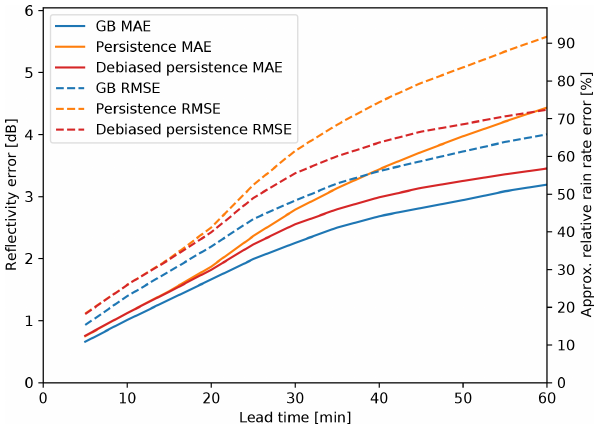
Figure 4. Errors (in dBZ) of the prediction of MAXZ as a function of lead time, obtained using all the available data. The solid lines show the mean absolute error (MAE), while the dashed lines show the root-mean-square error (RMSE) as shown on the scale on the left. The scale on the right shows the logarithmic reflectivity error converted to the relative error in rain rate R . The blue lines show the result from the GB tree, the orange lines show the Lagrangian persistence assumption and the red lines show the bias-corrected Lagrangian persistence.